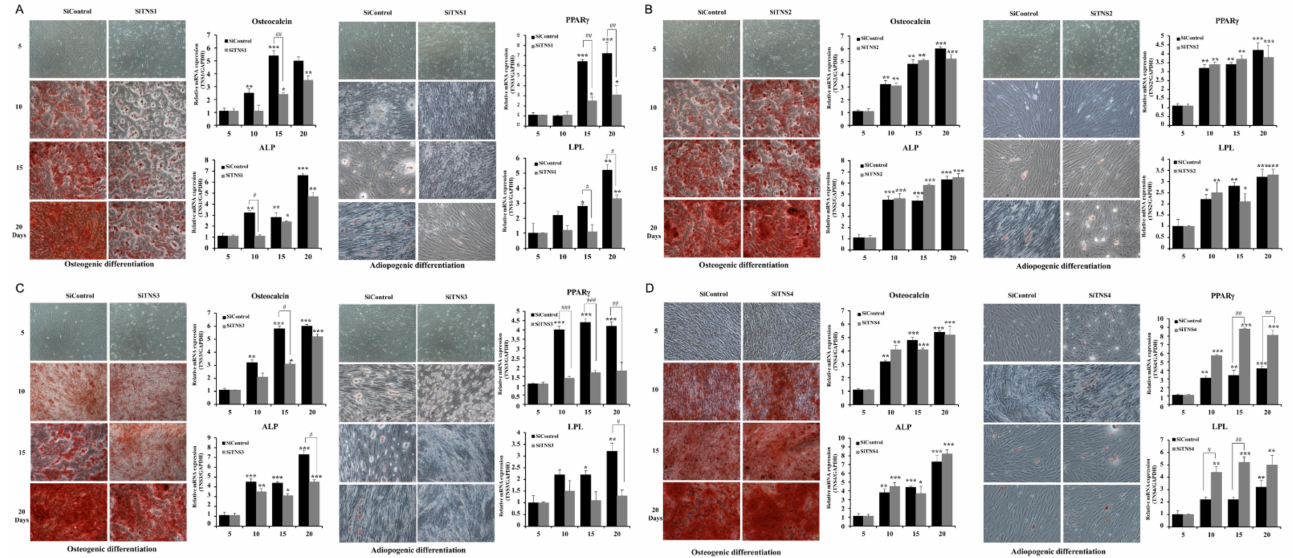
Figure 5. Tensin controls osteogenic and adipogenic differentiation of tonsil mesenchymal stem cells (TMSCs). ( A ) In the osteogenic differentiation medium, siTNS1 treatment reduced the Alizarin Red S staining suggesting a lower expression of osteocalcin and ALP from 10 days compared to that in the siControl-treated cells. In the adipogenic differentiation medium, siTNS1-treated cells showed a significantly reduced number of lipid droplets and reduced PPAR γ and LPL expression. ( B ) SiTNS2-transfected TMSCs showed no osteogenic or adipogenic differentiation compared to that in siControl TMSCs. ( C ) siTNS1 and siTNS3 demonstrated similar results in terms of osteogenic and adipogenic differentiation. ( D ) Transfection with siTNS4 revealed no change in osteogenic differentiation but led to an increase in adipogenic differentiation. * p < 0.05, ** p < 0.01, *** p < 0.001, compared to five days. # p < 0.05, ## p < 0.01, and ### p < 0.001, compared to siControl. n = 4. Columns and error bars represent mean ± standard